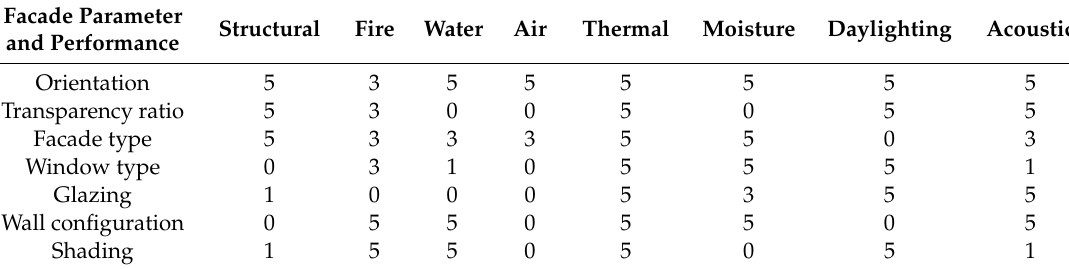
Table 1. Weights of the